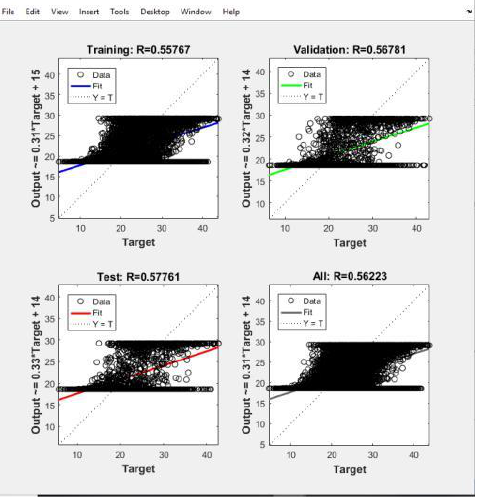
Figure 23 . The three plots represent the training, validation, and testing data. The dashed line in each plot represents the perfect result – outputs = targets. The solid line represents the best fit linear regression line between outputs and targets. The R value is an indication of the relationship between the outputs and targets. If R = 1, this indicates that there is an exact linear relationship between outputs and targets. If R is close to zero, then there is no linear relationship between outputs and